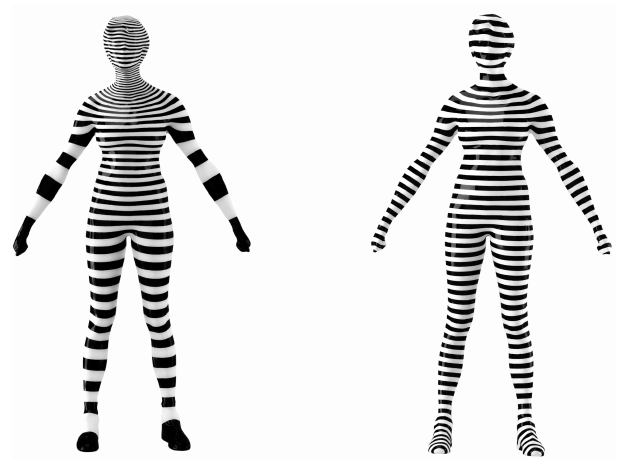
Figure 17. Obtaining a unit gradient scalar